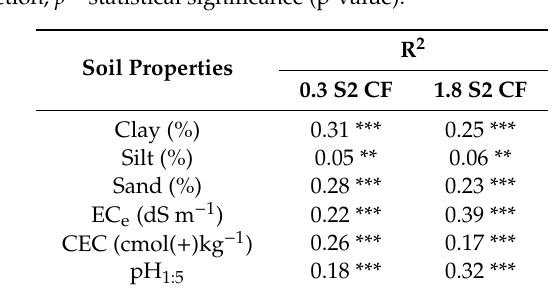
Table 3. Coe ffi cient of determination (R 2 ) between selected estimates of true electrical conductivity ( σ —mS m − 1 ) and various soil properties. Note: soil salinity of saturated soil paste extract (EC e —dS m − 1 ) estimated from measured electrical conductivity from a 1-part soil to 5-parts water extract (EC 1:5 ), cation exchange capacity (CEC—cmol( + ) kg − 1 ) and pH of a 1-part soil to 5-parts water extract (pH 1:5 ). CF—cumulative function, p —statistical significance (p-value).